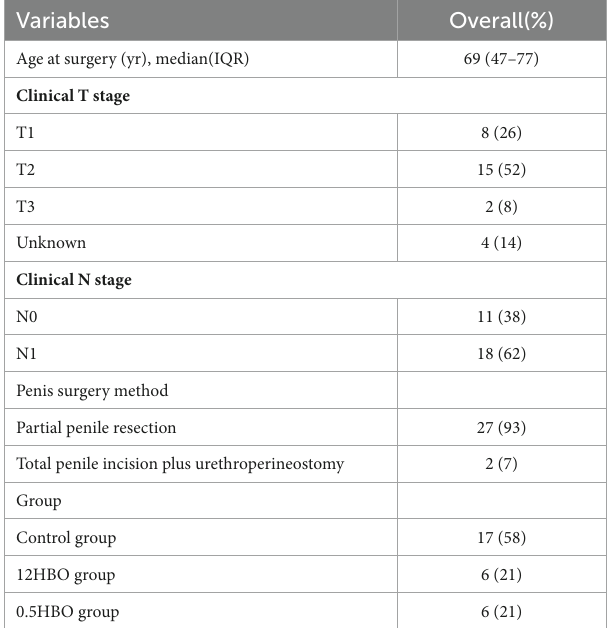
TABLE 1 Descriptive characteristics of the entire cohort of 29 patients with ≥ pT1G2 and cN0 penile squamous cell